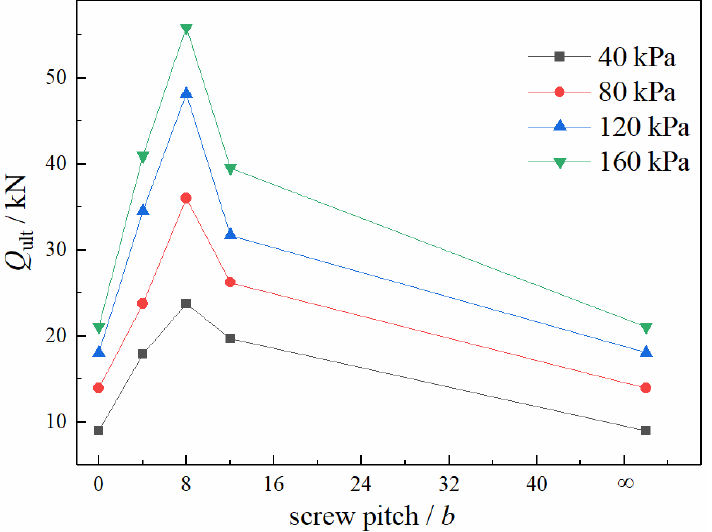
Figure 9. Variation curves of the ultimate bearing capacity of the screw shear plates. Remarkably, Figure 9 confirms the existence of an optimal screw pitch for the screw pile. According to the test results, the optimal screw pitch was 8 b . The bearing capacity